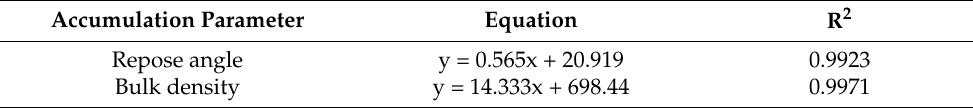
Table 6. The result of linear fitting. Accumulation Parameter Equation R 2 Repose angle y = 0.565x + 20.919 0.9923 Bulk density y = 14.333x + 698.44